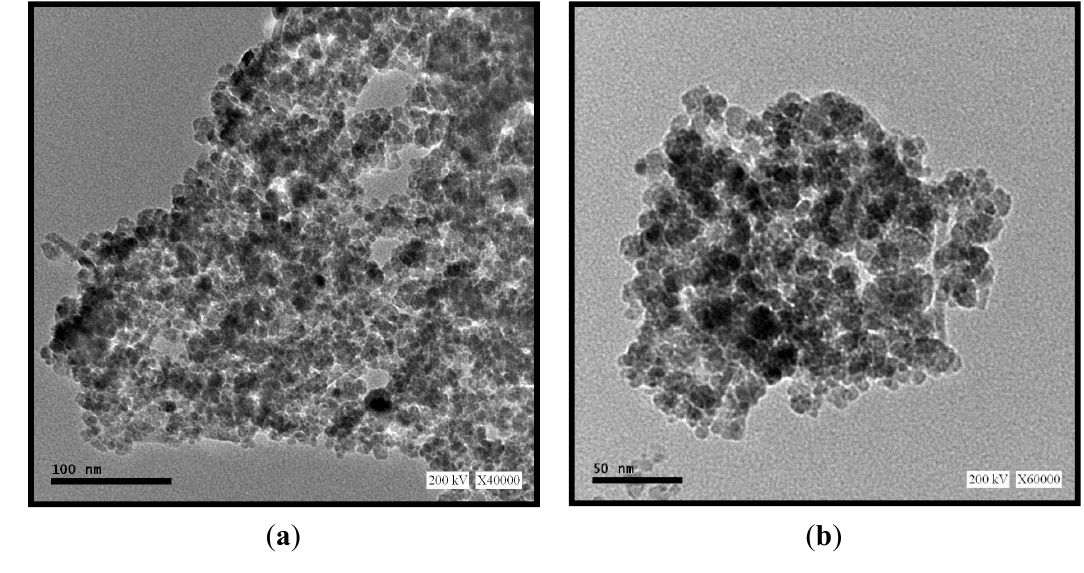
Figure 4. TEM micrographs (the scale bars are ( a ) 100 and ( b ) 50 nm,